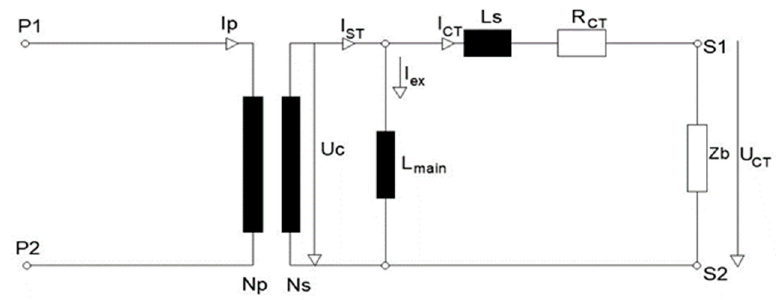
Figure 7. Reduced model of current transformer.